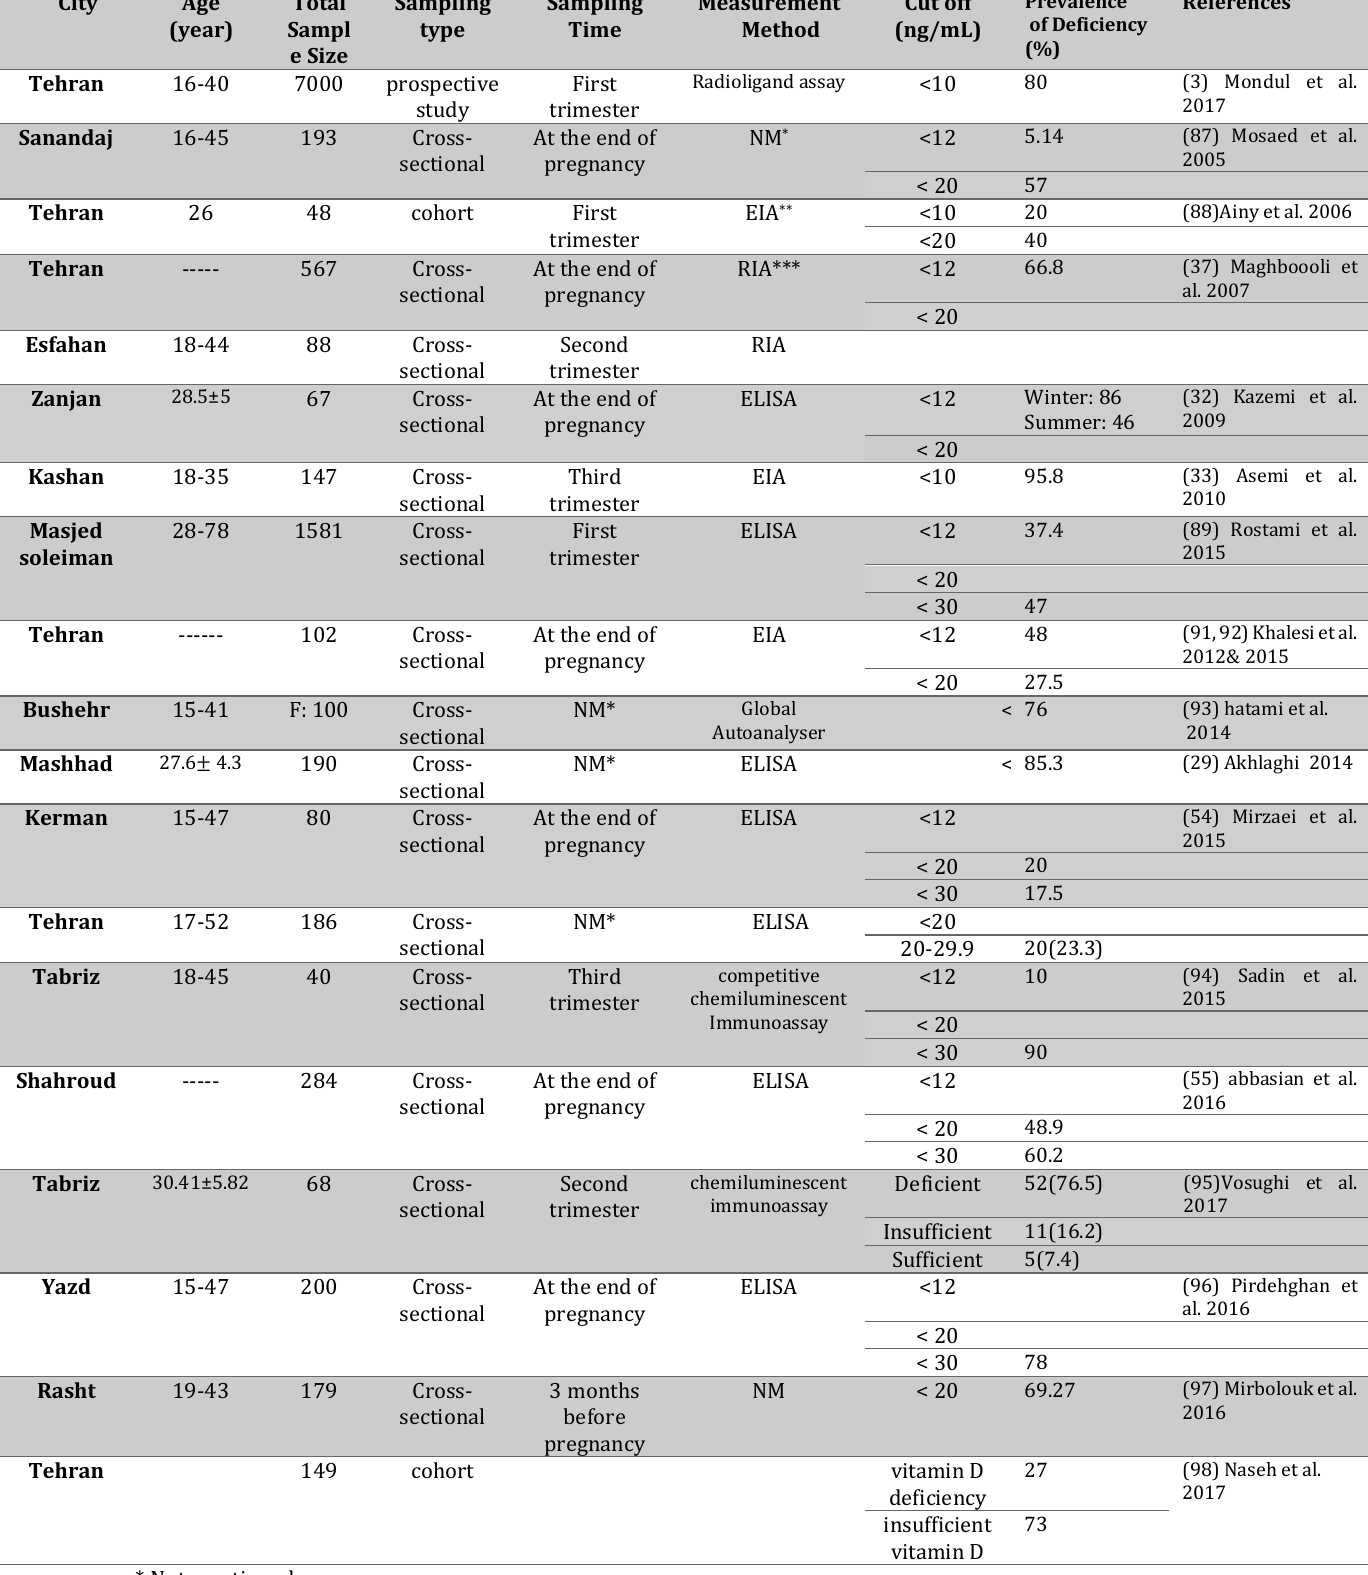
Table 1 . Characteristics and results from studies on the prevalence of vitamin D deficiency or insufficiency for pregnant women in